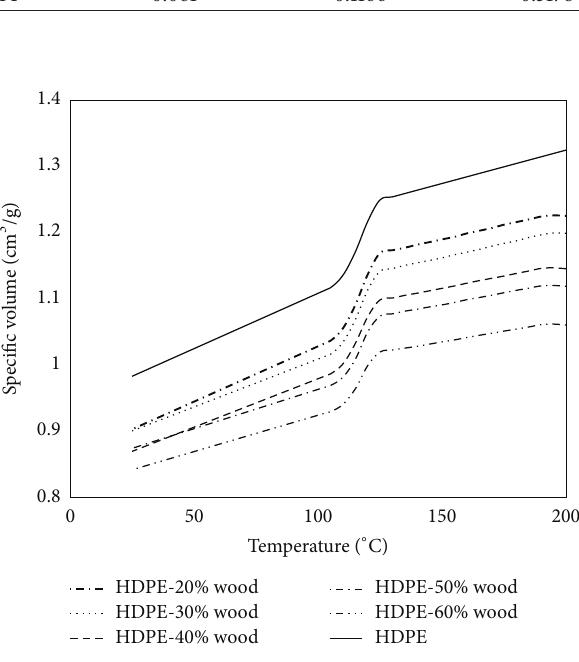
Figure 4: Specific volume variation as a function of filler